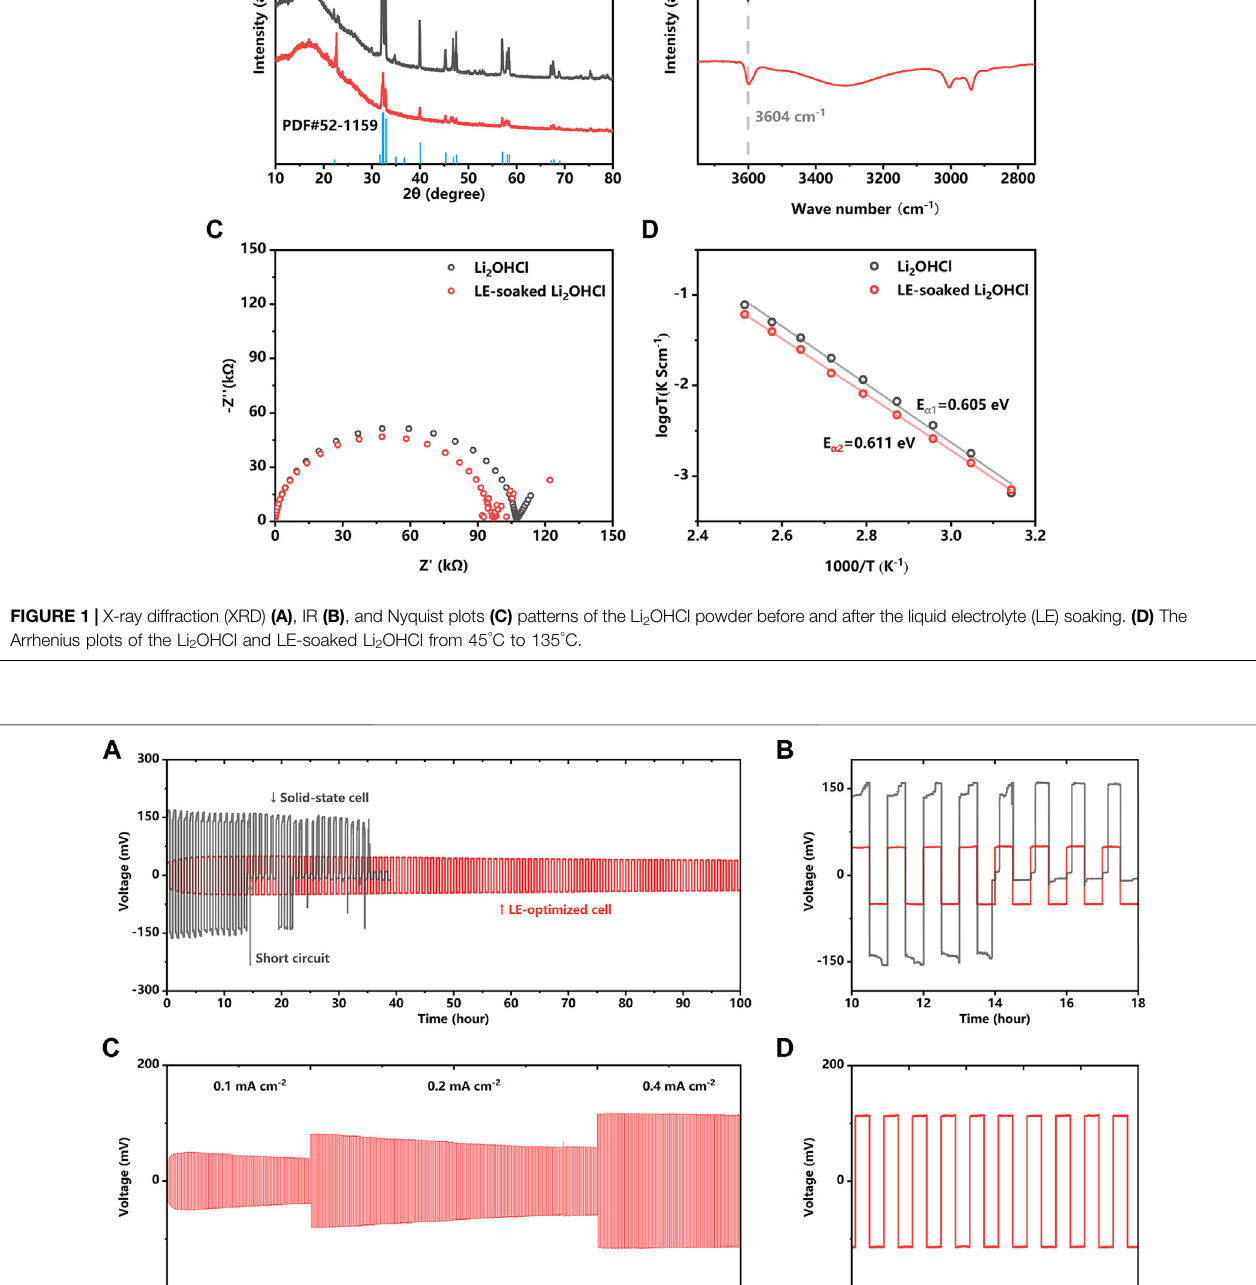
− 2 . (C,D) Galvanostatic cycling of